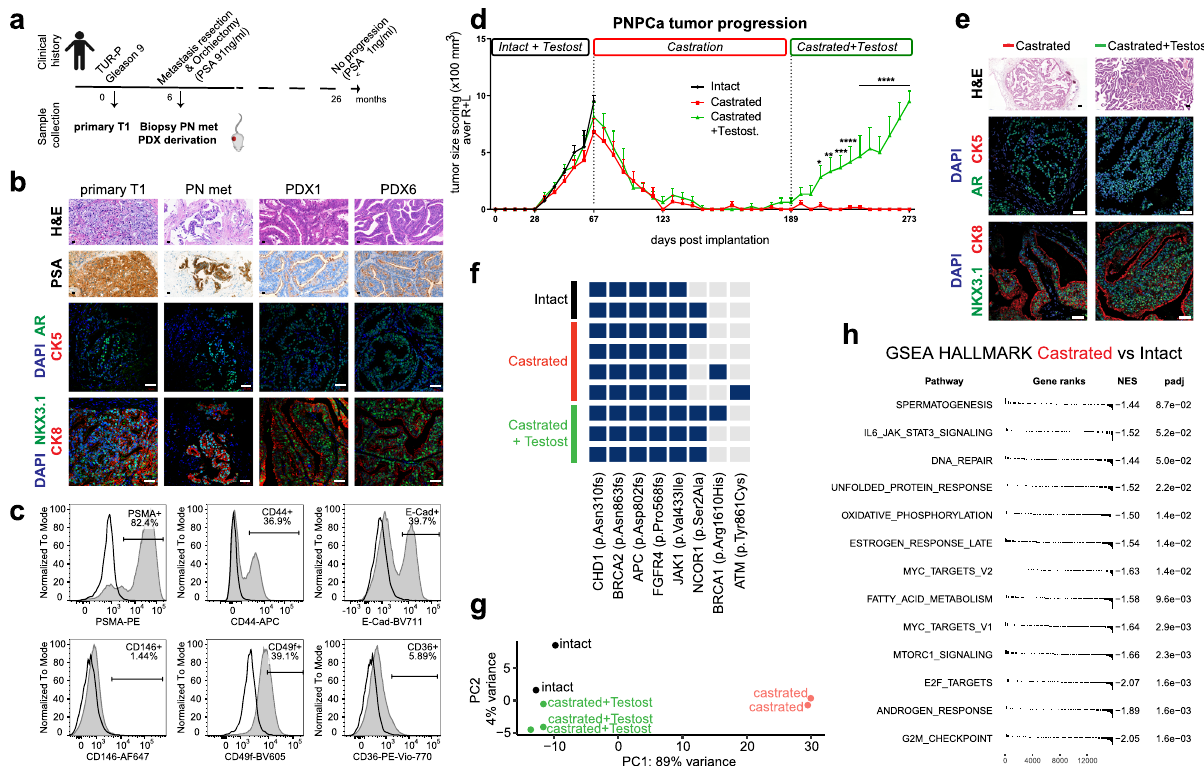
Fig. 1 Establishment of a novel androgen dependent, patient-derived xenograft from an early, treatment-naïve prostate cancer metastasis. a Scheme of clinical history and patient-derived samples: primary tumor TUR-P (T1) and penile metastasis needle biopsies used to establish the PDX model (PNPCa) and subsequent passages. Created with BioRender.com. b Histological morphology of primary TURP tumor, penile metastasis (PN met) from PCa and the PDX passages 1 and 6 (PDX1, PDX6) derived from the metastasis needle biopsy implantation (PNPCa), as assessed by Hematoxylin and Eosin staining (H&E). Scale bars 20 μ m. Top to bottom panels : PSA protein expression. Scale bars 20 μ m. Expression of AR (green), CK5 (red) assessed by immuno fl uorescence, DAPI (blue) marks the nuclei. Scale bars 50 μ m. Expression of NKX3.1 (green), CK8 (red) assessed by immuno fl uorescence. Scale bars 50 μ m. c Flow cytometry analysis of epithelial and prostate-speci fi c marker expression in PNPCa PDX tissue. FcR-blocked PNPCa cells were stained with antibodies against CD44, E-Cadherin, PSMA, CD49f, CD36, and CD146. d PDX tumor growth progression in time. Groups; 1. Intact tumors (collected at max size, N = 2 independent animals), 2. Castrated ( N = 5 independent animals), 3. Castrated followed by Testosterone re-administration (Castrated- Testosterone independent animals) starting on day 189 ( N = 4, N = 3 from day 203 to 252, N = 2 from day 252 to 273). Tumor scoring was performed weekly by routine palpation; values represent average calculation of the tumors of all animals per group (considering N = 2 tumors, left L and right R of each animal). Error bars represent SEM, calculated considering number of animals for each time point. Ordinary two-way ANOVA with Tukey ’ s multiple comparison correction was performed. (*) p = 0.0105 day 217, (**) p = 0.0025 day 224, (***) p = 0.0005 day 231, (****) p ≤ 0.0001 from day 238 onwards. e Top to bottom panels : Histological H&E staining of representative tumors from Castrated and Castrated-Testosterone hosts. Immuno fl uorescence staining for AR and CK5, CK8, NKX3.1 and CK8, CD44, and Ki67. DAPI marks the nuclei. Scale bars 50 μ m. f Genomic analysis of PNPCa PDXs from intact and castrated animals, collecting samples at full regression (122 days) and after further testosterone replacement (84 days). g Principal component analysis of the gene expression of the 500 most variable genes. h Gene set enrichment analysis plot of statistically signi fi cant (adjusted p -value < 0.05) enrichment of HALLMARK pathways based on the differential expression analysis of the Castrated versus the Intact groups. NES, normalized enrichment